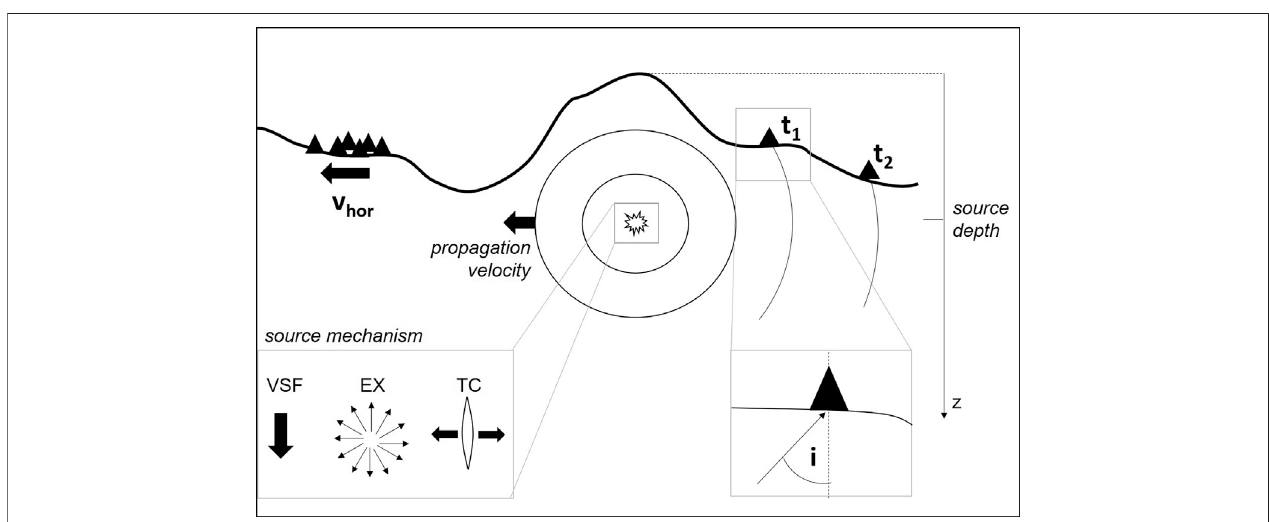
FIGURE1| Summary ofobservations (bold) used todetermine source properties(italic). The observed arrival times t j and the horizontal velocityv hor (slowness) are used to estimate the propagation velocity in the subsurface. The results of numerical modeling of seismic wave propagation are then compared to the observations (including the particle motion with incident angle i) to get information about the dominant source mechanism and source depth. VSF: vertical single force; EX: explosion source; TC: tensile crack.